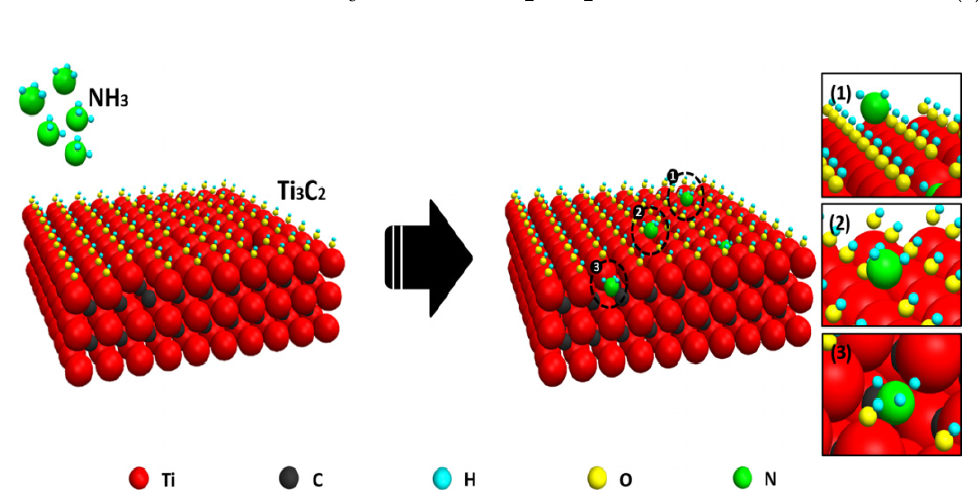
Figure 8. Schematic illustration of the possible MXene gas sensing mechanism. Reprinted with permission from [7]. Copyright © 2017, American Chemical Society.